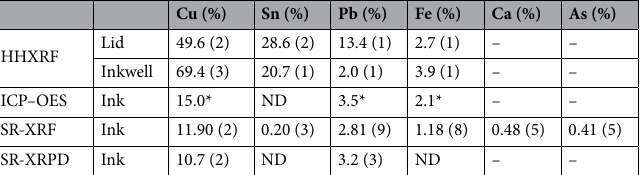
Table 2. Percentages of the main metals revealed both in the inkwell and ink powder by HHXRF, ICP-OES, SR-XRF, SR-XRPD. *RDS < 5%.